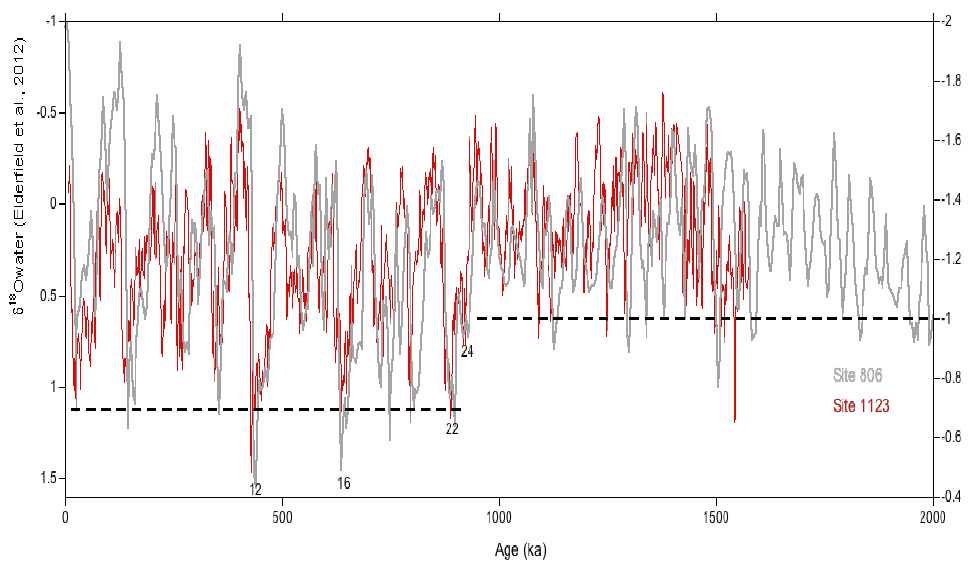
Figure 11. Comparison of the deconvolved oxygen isotope signal of seawater ( δ 18 O water ) from ODP Site 1123 (red; Elderfield et al., 2012) and the δ 18 O record of the shallow-dwelling Globigerinoides sacculifer from Site 806 on the Ontong Java Plateau (gray; Berger et al., 1993, 1994). Note the abrupt increase in δ 18 O of glacial stages following 900ka after MIS